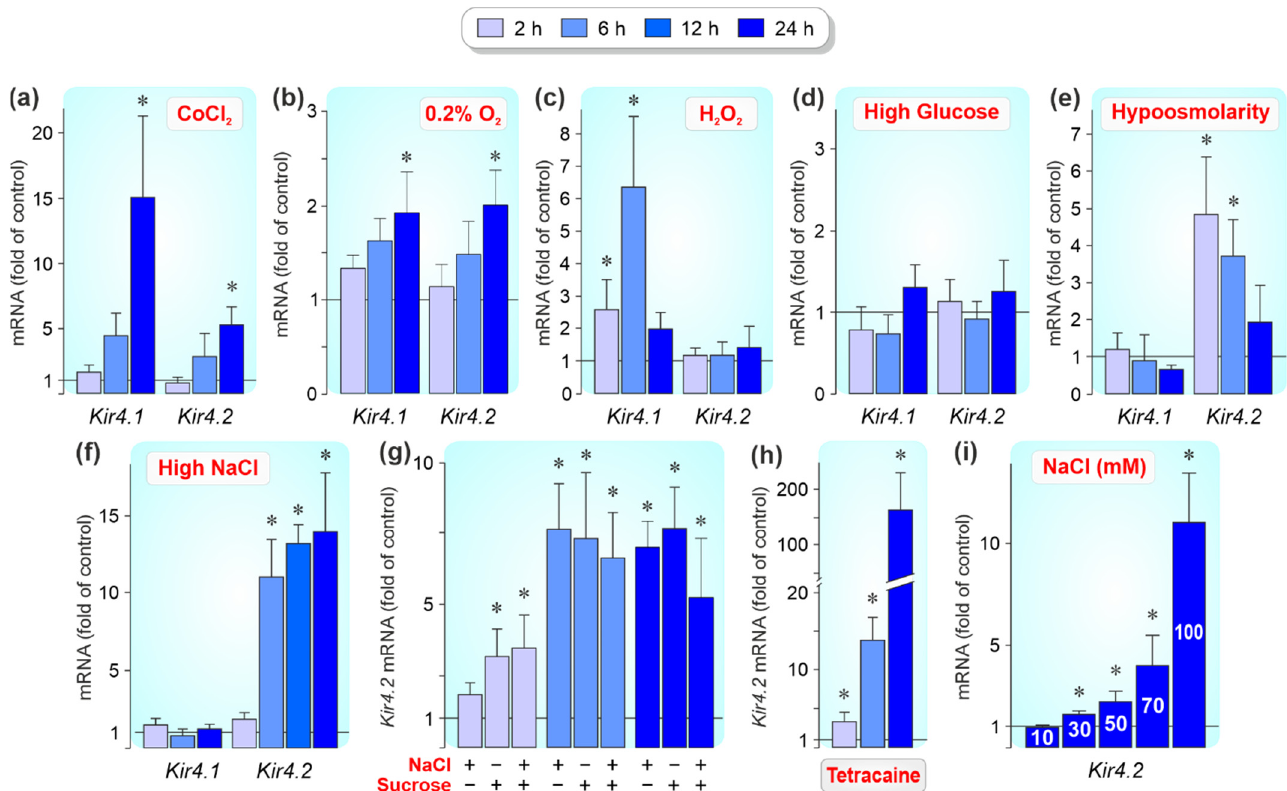
Figure 3. Regulation of Kir4.1 and Kir4.2 gene expression in cultured RPE cells by pathogenic conditions. Real-time RT-PCR was carried out with RNA extracted from cells which were stimulated 2, 6, and 24 h. In ( f ), a 12-h stimulation was also examined on Kir4.2 gene expression. Relative mRNA levels are shown as folds of unstimulated control (1). ( a ) Effects of chemical hypoxia, induced by adding 150 µM CoCl 2 , on the Kir channel gene expression. ( b ) Effect of cell culture in a 0.2% O 2 - atmosphere. ( c – f ) Effects of oxidative stress (20 µM H 2 O 2 ; ( c )), hyperglycemia (25 mM glucose; ( d )), extracellular hypoosmolarity (60% osmolarity; ( e )), and hyperosmolarity (+100 mM NaCl; ( f )). ( g ) Effects of hyperosmotic media prepared by adding 100 mM NaCl or 200 mM sucrose, or by coaddition of NaCl and sucrose, on the Kir4.2 gene expression. ( h ) Effect of tetracaine (1 mM) on the Kir4.2 mRNA level. ( i ) Dose-dependent effect of high NaCl on the Kir4.2 mRNA level. Different concentrations (10–100 mM) of NaCl were added to the culture media. Each bar shows data derived from 3–9 independent experiments with cells of different donors. Significant difference vs.